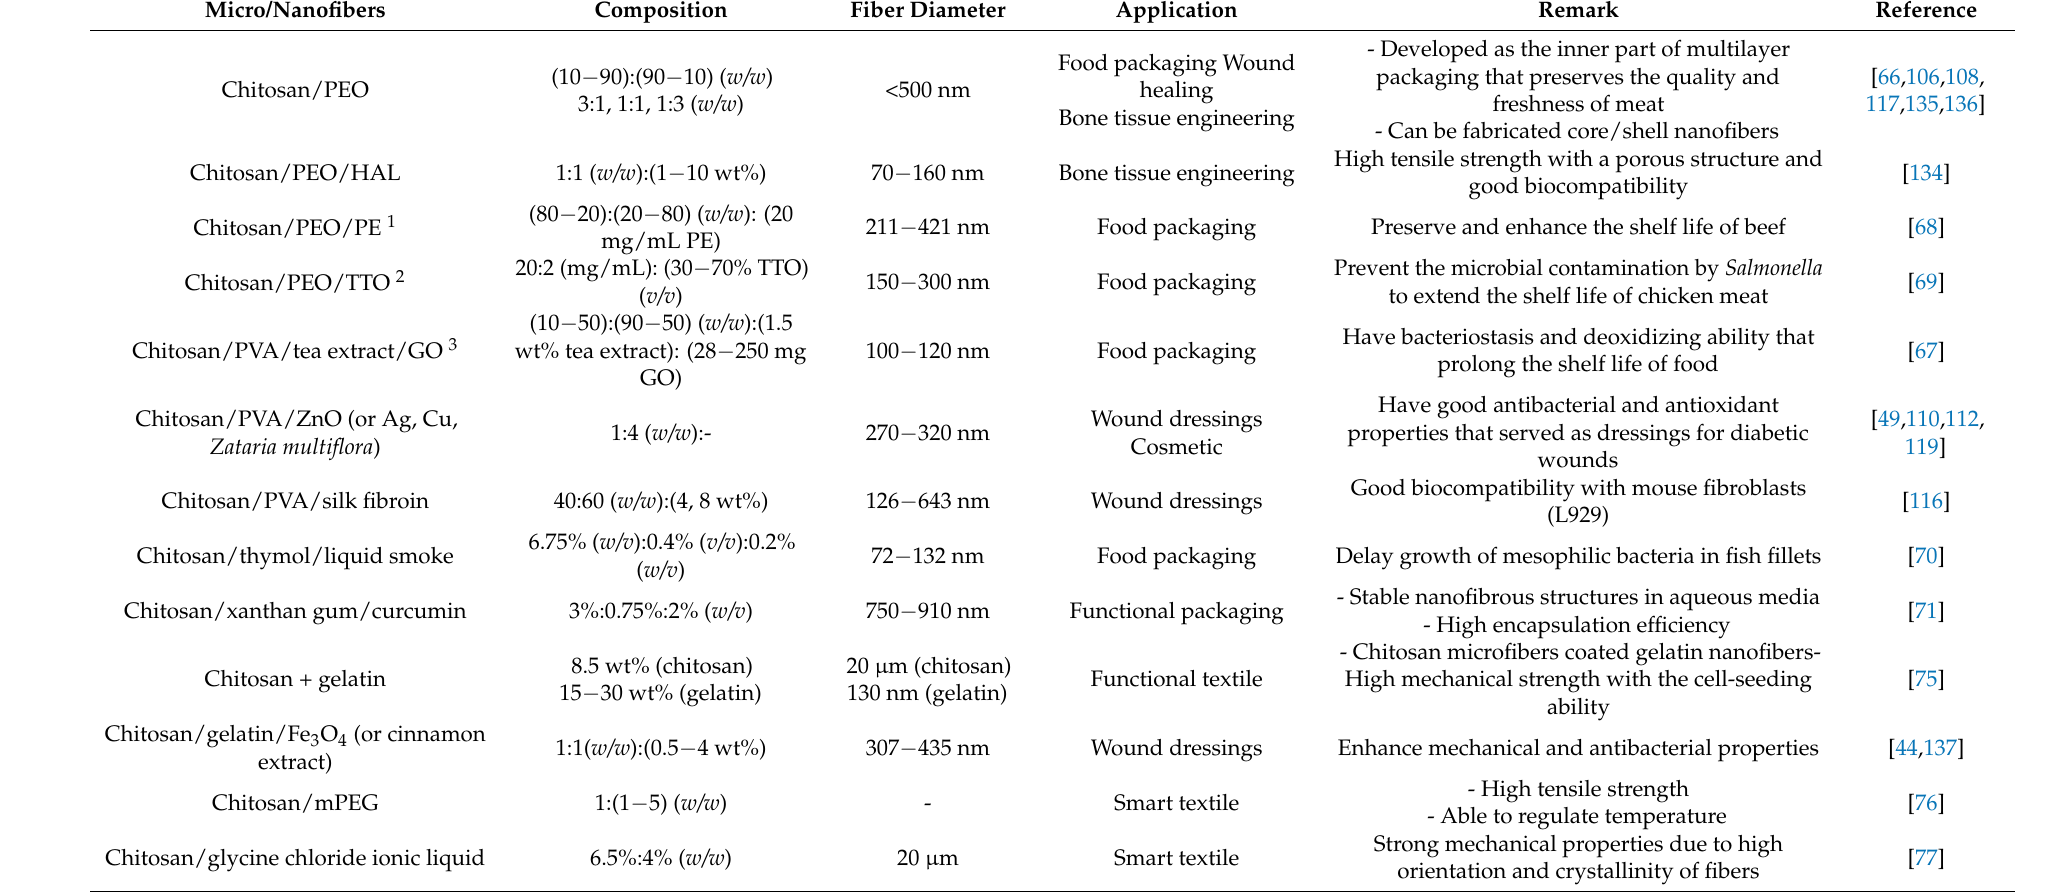
Table 2. Summary of chitosan-based micro/nanofibers for sustainable food packaging, smart textiles, cosmetics, biomedical applications, and their